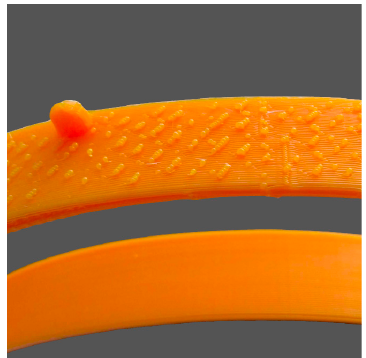
Figure 12. Visible infill from the outside.